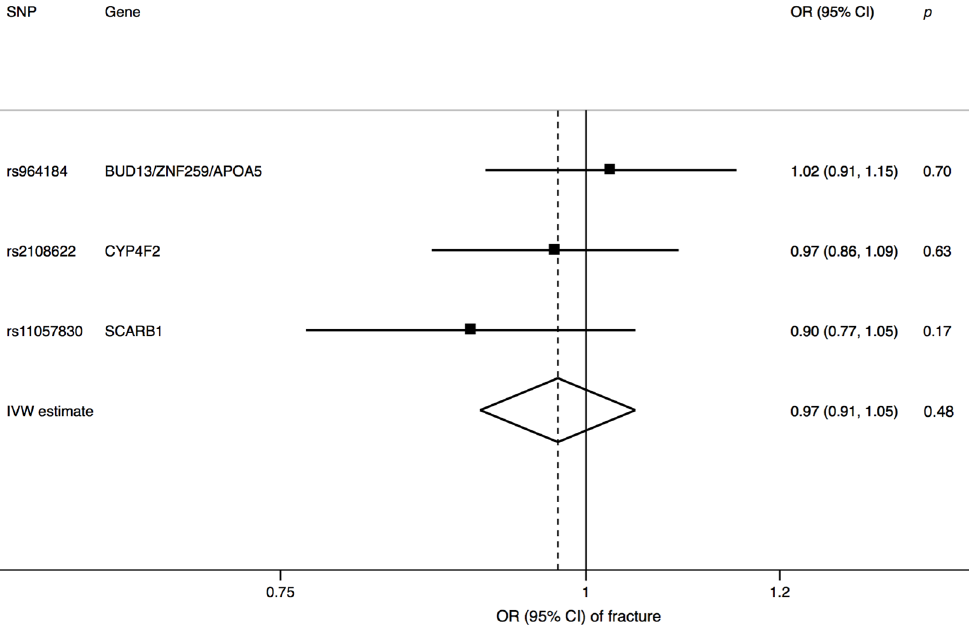
Figure 2. Association between genetically predicted one-standard-deviation increase in circulating α -tocopherol and fracture risk. CI, confidence interval; IVW, inverse, variance weighted; OR, odds ratio; SNP, single-nucleotide polymorphism.